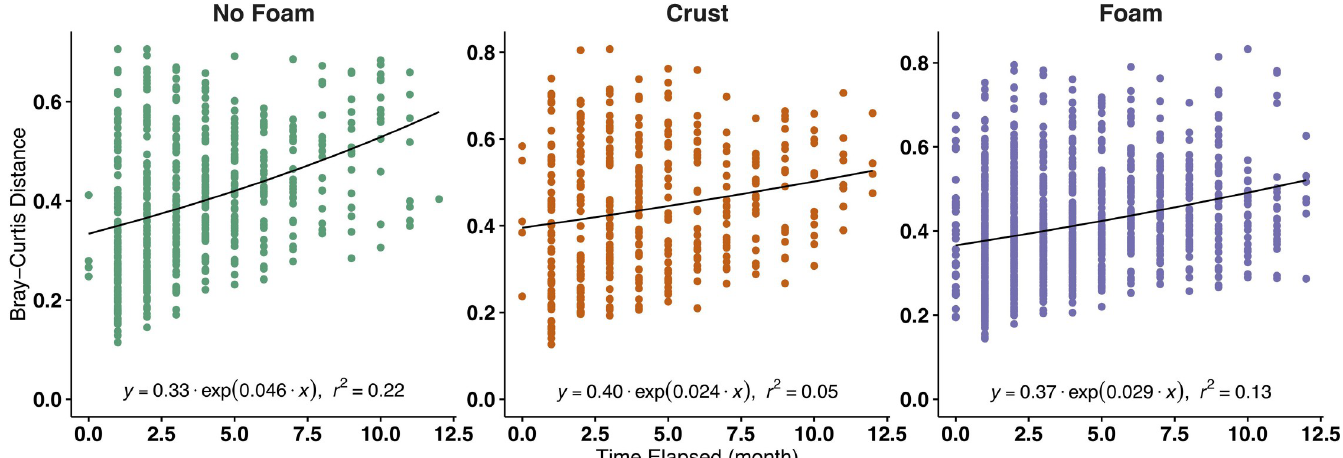
Fig 4. The manure-associated community dissimilarity as a function of time (y = a•exp(b•x)), where a smaller slope (b) suggests a smaller dissimilarity over time. Distribution of slopes was estimated by bootstrapping each group of samples 999 times. The slope estimated for non-foaming samples was significantly greater than those estimated for crust-forming and foaming samples (overlap coefficient =